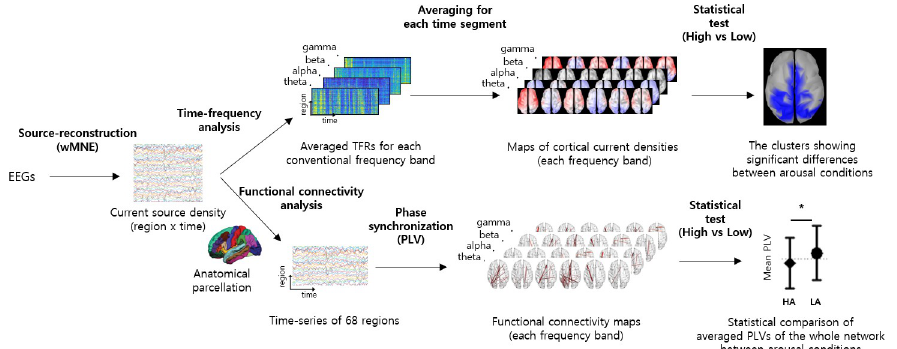
Fig 2. Procedure for EEG data analysis. The upper and lower parts of the Fig 2 present the procedures for the comparisons of cortical current source strength and inter-regional phase synchronization between high and low